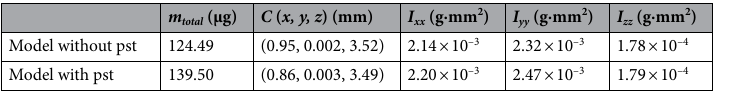
Table 2. Total masses, centers of mass and moments of inertia for hind wing models without/with a pst structure ( m total denotes the total hind wing mass, C ( x , y , z ) is the center of mass, and I xx , I yy , and I zz represent the moments of inertia about the x, y and z axes, respectively).